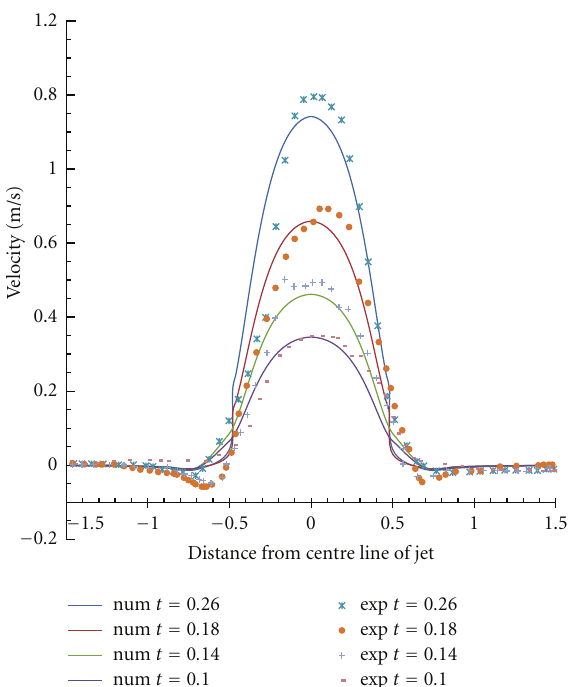
Figure 6: Comparison of experimental and numerical streamwise component of velocity profiles at orifice exit during the four phases of the expulsion phase.